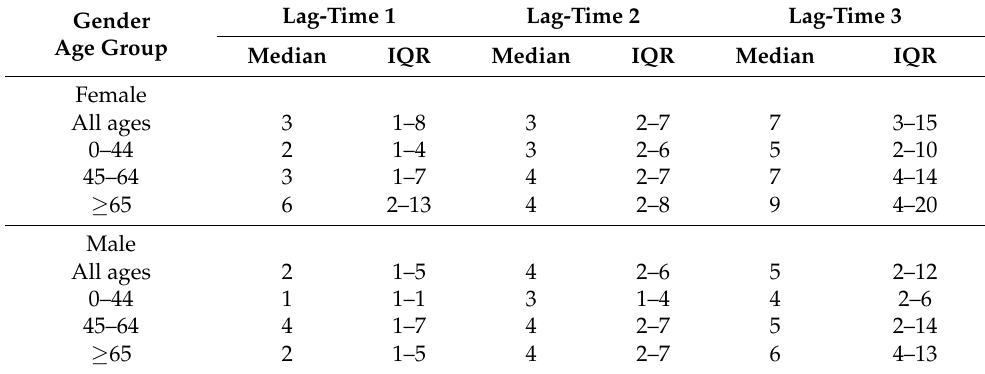
Table 3. Number of outpatient visits of three lag times for primary Sjögren’s